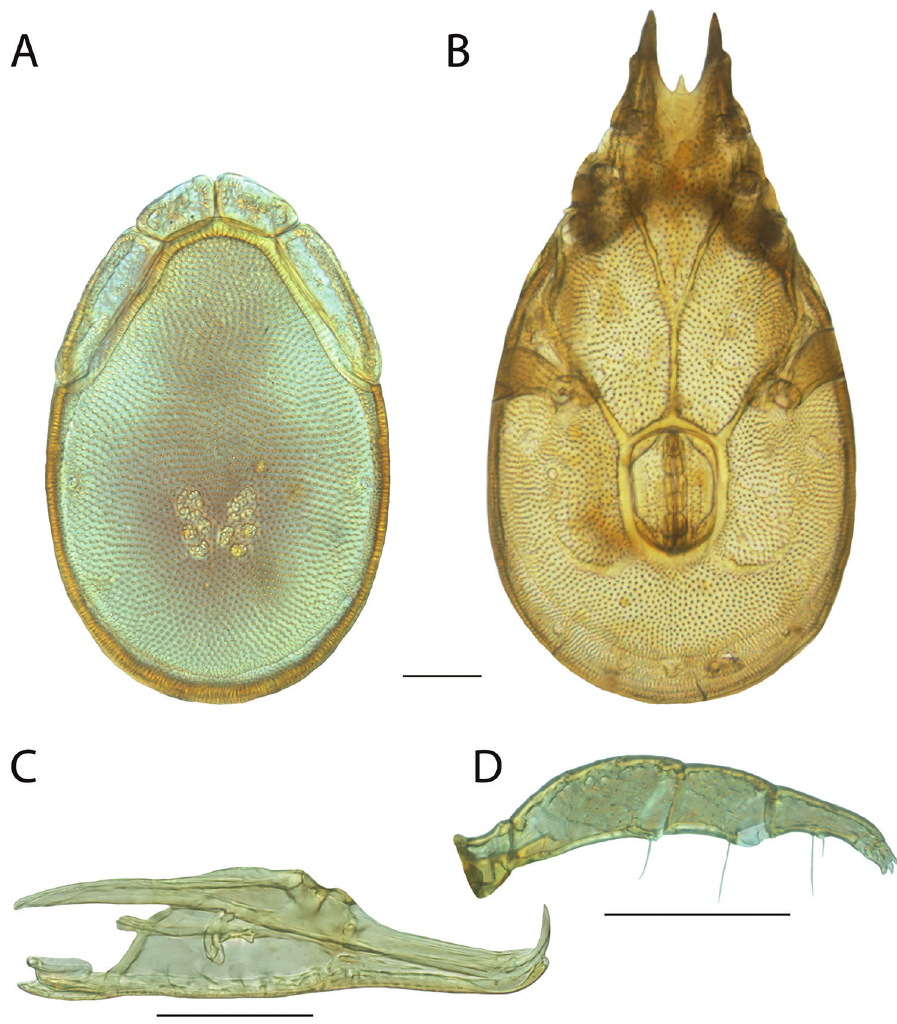
Figure 201. Torrenticola projector male: A dorsal plates B venter (legs removed) C subcapitulum D pedipalp (setae not accurately depicted). Scale = 100